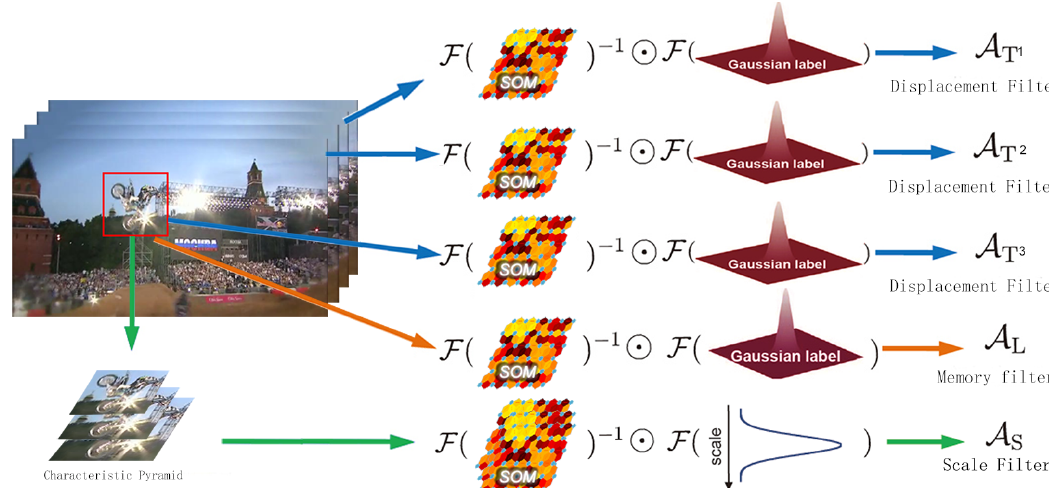
Figure 2. SOM feature extraction and correlation filters. The translation filter A T 1 , A T 2 and A T 3 with short-time memory adapts to changing appearance of the target and its surrounding context. The long-time memory filter A L is conservatively learned to maintain the long-time memory of the target